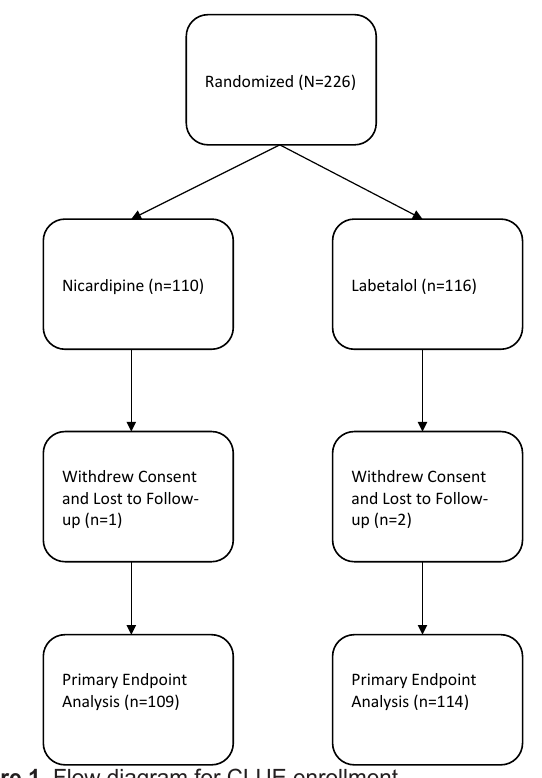
Figure 1. Flow diagram for CLUE